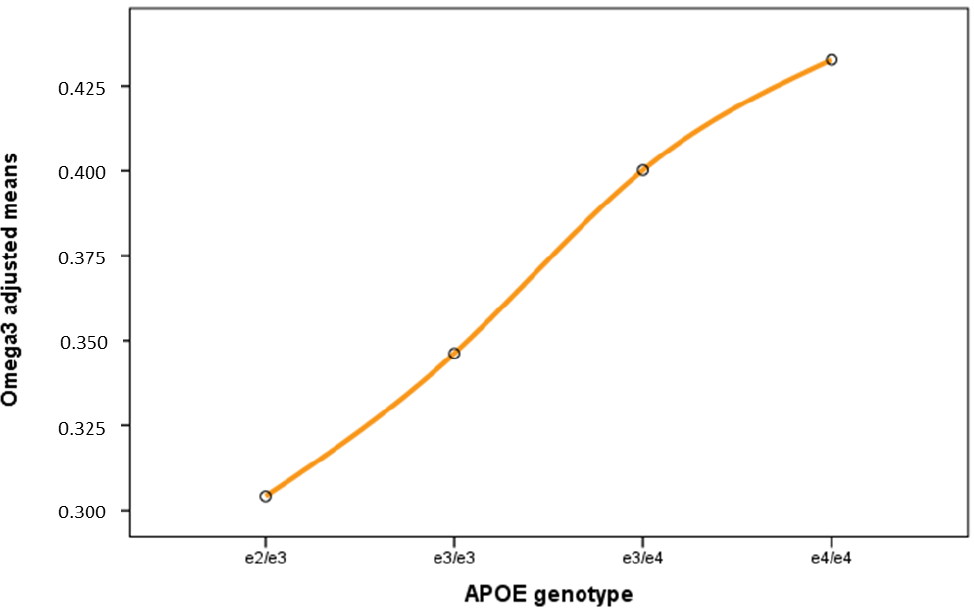
Figure 4. Adjusted effect of the APOE genotypes in the plasma levels of omega3 fatty acids (Night- ingale FAw3). Sample size (n) 136. Adjusting covariates in the model are age, Sex, L-HDL-C(%), and personal antecedents of hypertension and dyslipidemia.